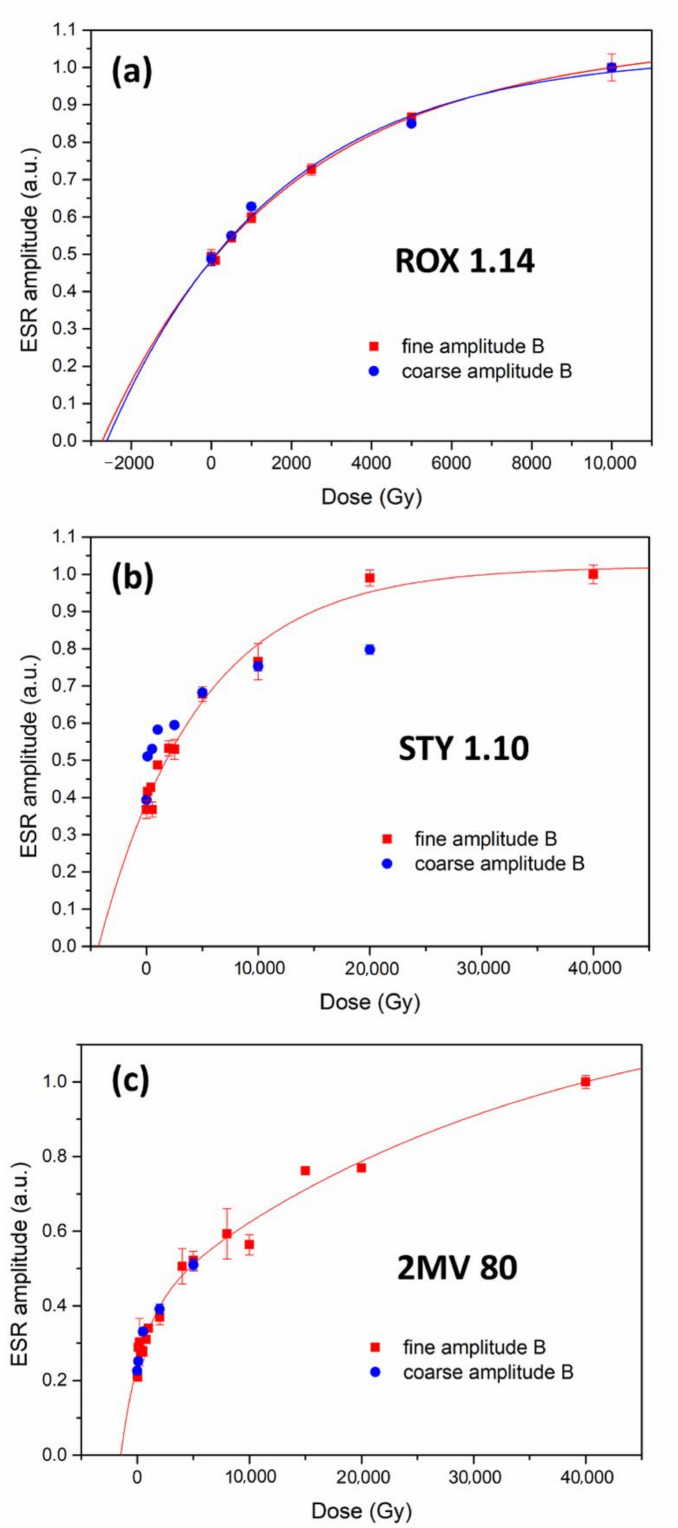
Figure 6. Dose response curves for the amplitude B exp obtained for fine (4–11 µ m) and coarse (125–180 µ m) grains of samples ROX 1.14 ( a ), STY 1.10 ( b ), and fine (4–11 µ m) and coarse (63–90 µ m) grains of sample 2 MV 80 ( c ). Data were normalised to the maximum datapoint ( a ) or maximum datapoint for fine grains and overlaid on the curve for coarse grains ( b , c ). Negative dose values indicate the dose accumulated in the material prior to laboratory